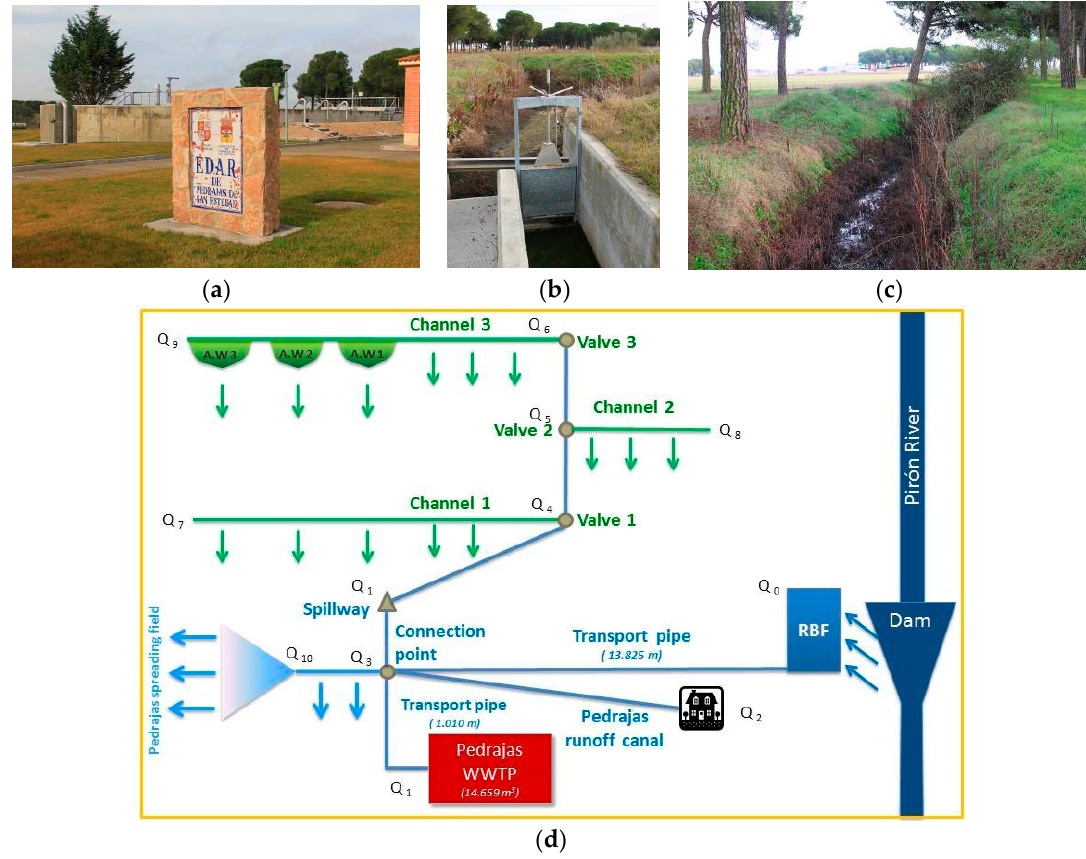
Figure 6. Alcazarén Area and its MAR components, Valladolid (Spain). Photos of some key points ( a ) Pedrajas waste water treatment plant (WWTP); ( b ). Connecting junction of water from WWTP, Pirón River abstraction and urban run-off channel; ( c ). Run-off canal from Pedrajas Village to the connection point; ( d ) General scheme.